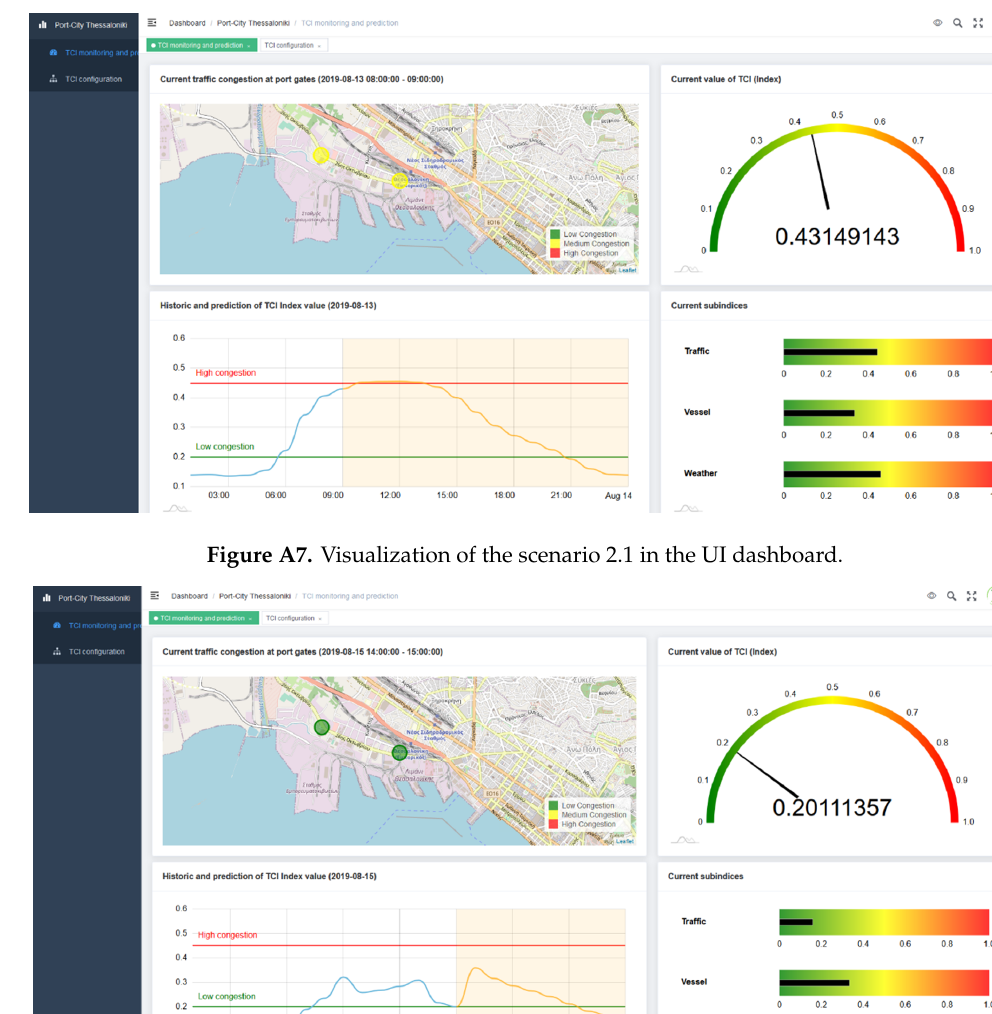
Figure A6. Visualization of the scenario 1.3 in the UI dashboard. Sensors 2020 , 20 , x FOR PEER REVIEW